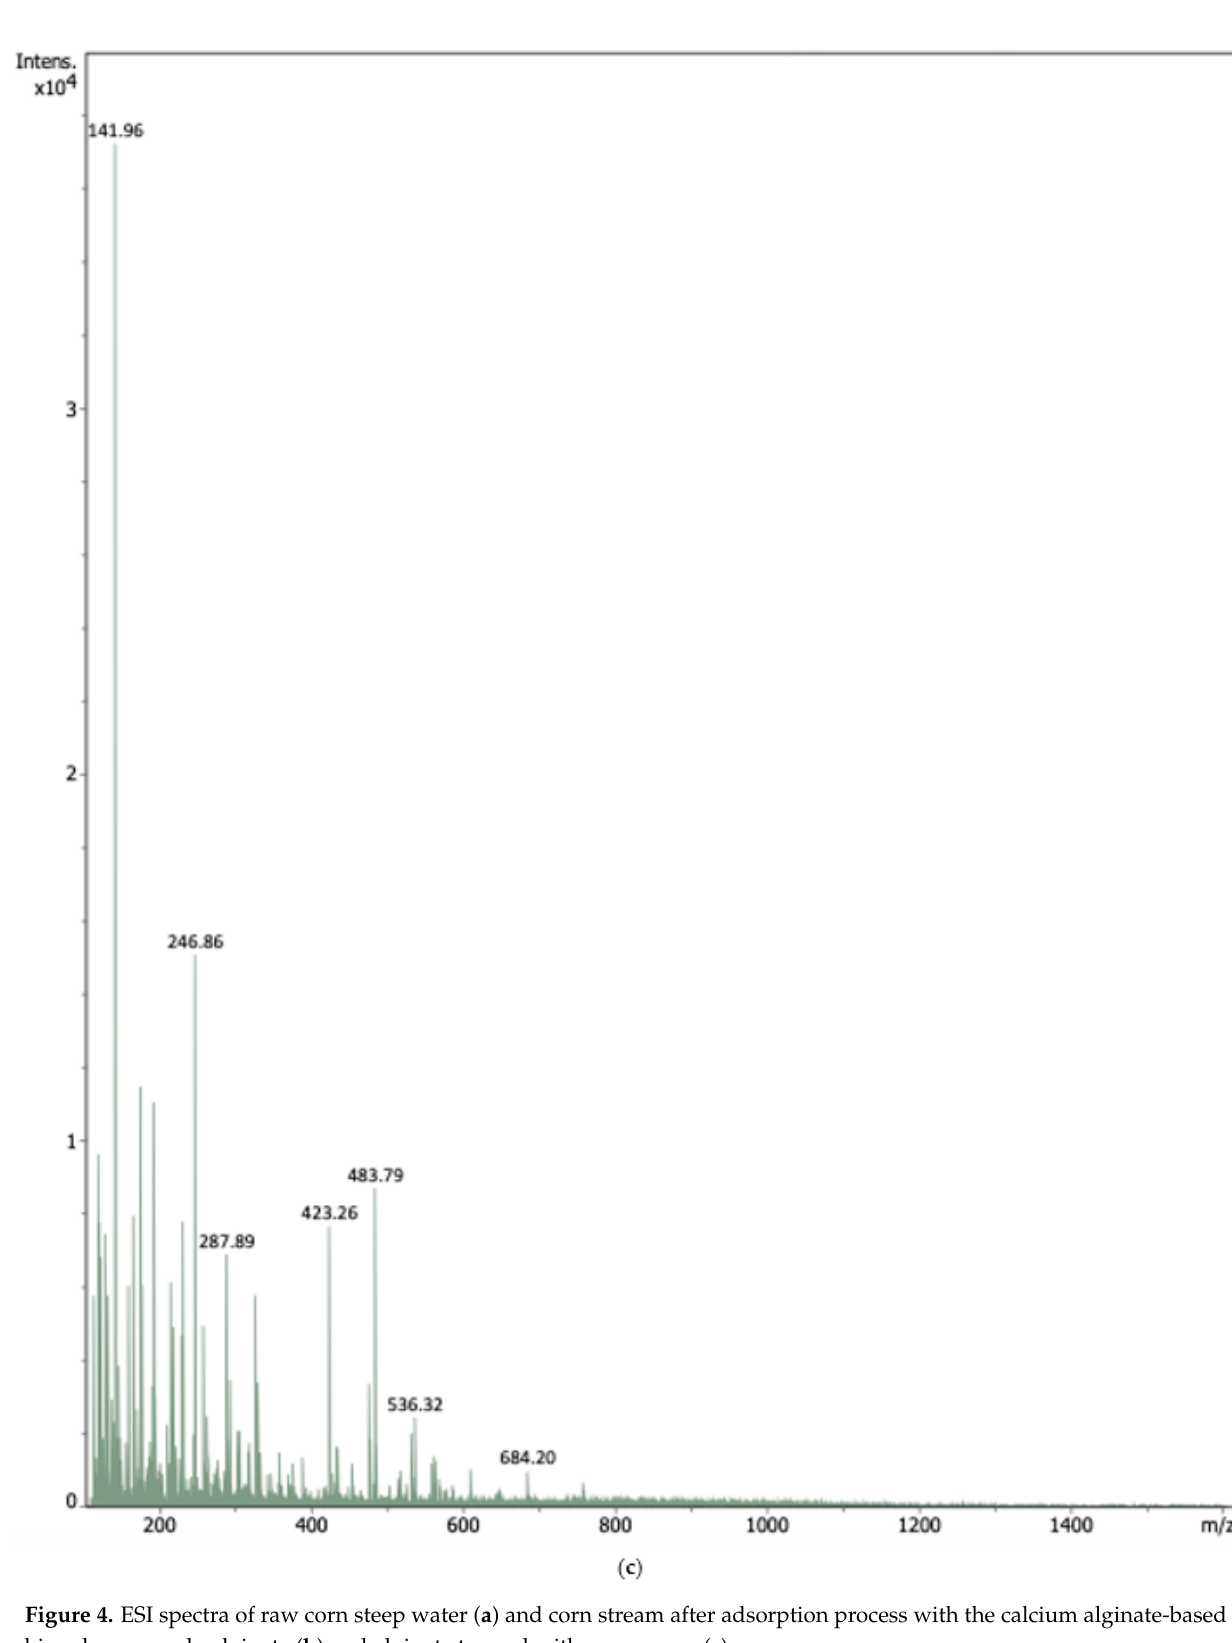
Figure 4. ESI spectra of raw corn steep water ( a ) and corn stream after adsorption process with the calcium alginate-based biopolymers, only alginate ( b ) and alginate tunned with grape marc ( c ).